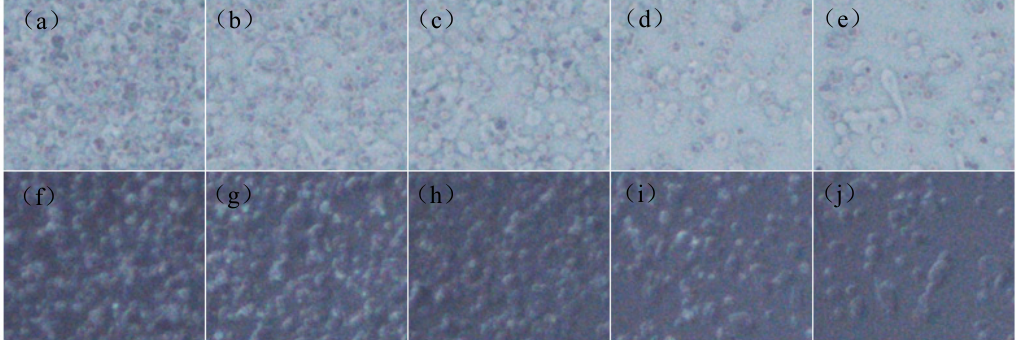
Figure 8. The digital microscope pictures of microstructure morphology of anti-glare sample by different the spray gun displacement speed ( a ) 170 mm/s (90 ◦ ); ( b ) 235 mm/s (90 ◦ ); ( c ) 300 mm/s (90 ◦ ); ( d ) 400 mm/s (90 ◦ ); ( e ) 500 mm/s (90 ◦ ); ( f ) 170 mm/s (25 ◦ ); ( g ) 235 mm/s (25 ◦ ); ( h ) 300 mm/s (25 ◦ ); ( i ) 400 mm/s (25 ◦ ); and ( j ) 500 mm/s (25 ◦ ) with the sol-gel deliver and air transport pressures of 120 kPa and 300 kPa, respectively.